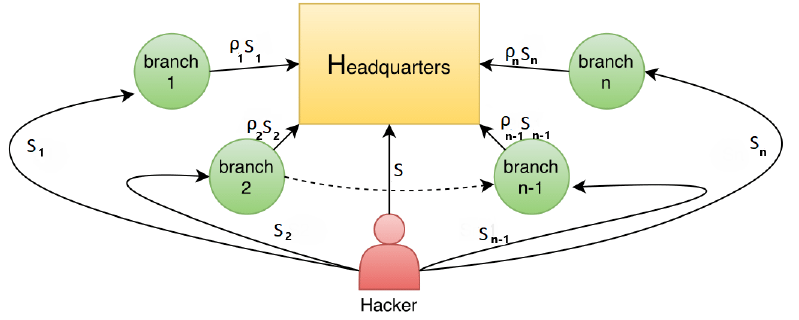
Figure 1. Cyber-security scheme for multi-branch